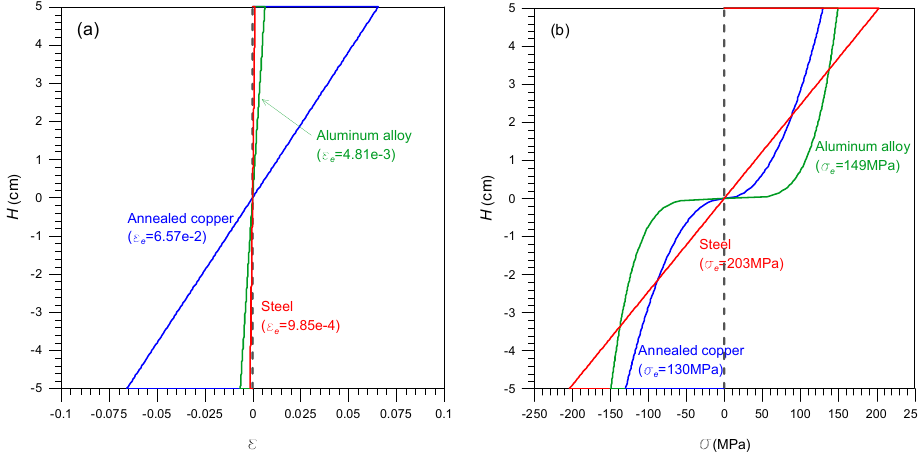
Figure 9. Values of ( a ) strain 𝜀 and ( b ) stress 𝜎 as functions of the distance 𝐻 from the neutral axis for steel, aluminum alloy, and annealed copper beams at clamped ends.